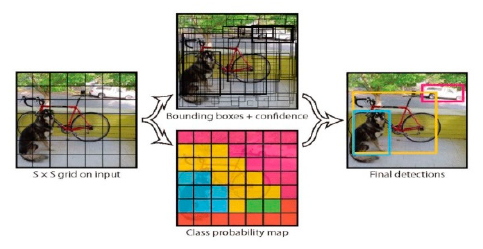
Figure 2. YOLO main organization blocks, source [27].